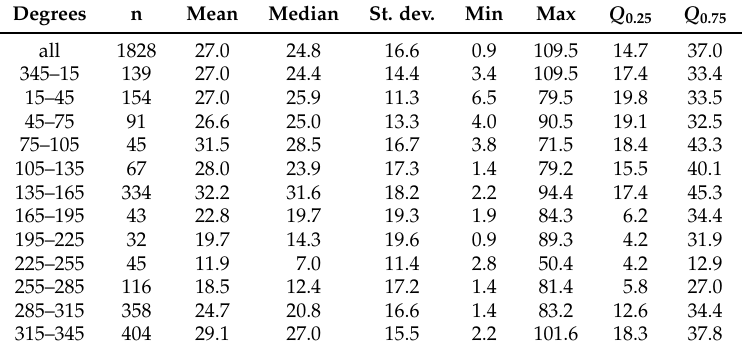
Descriptive statistics for PM 10 by wind direction: Arboretum station (n—the